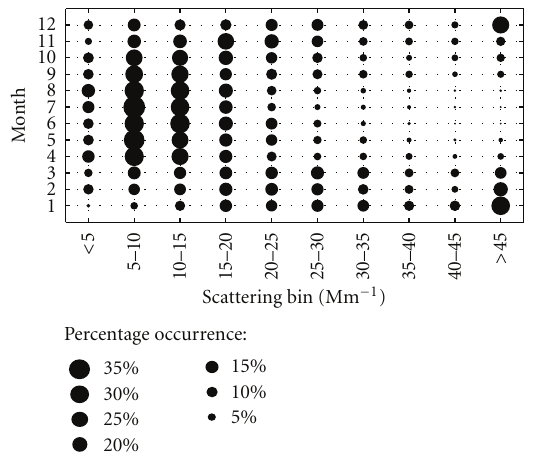
Figure 2: Percentage occurrence of σ scat values in di ff erent scatter- ing bins normalized over a month.